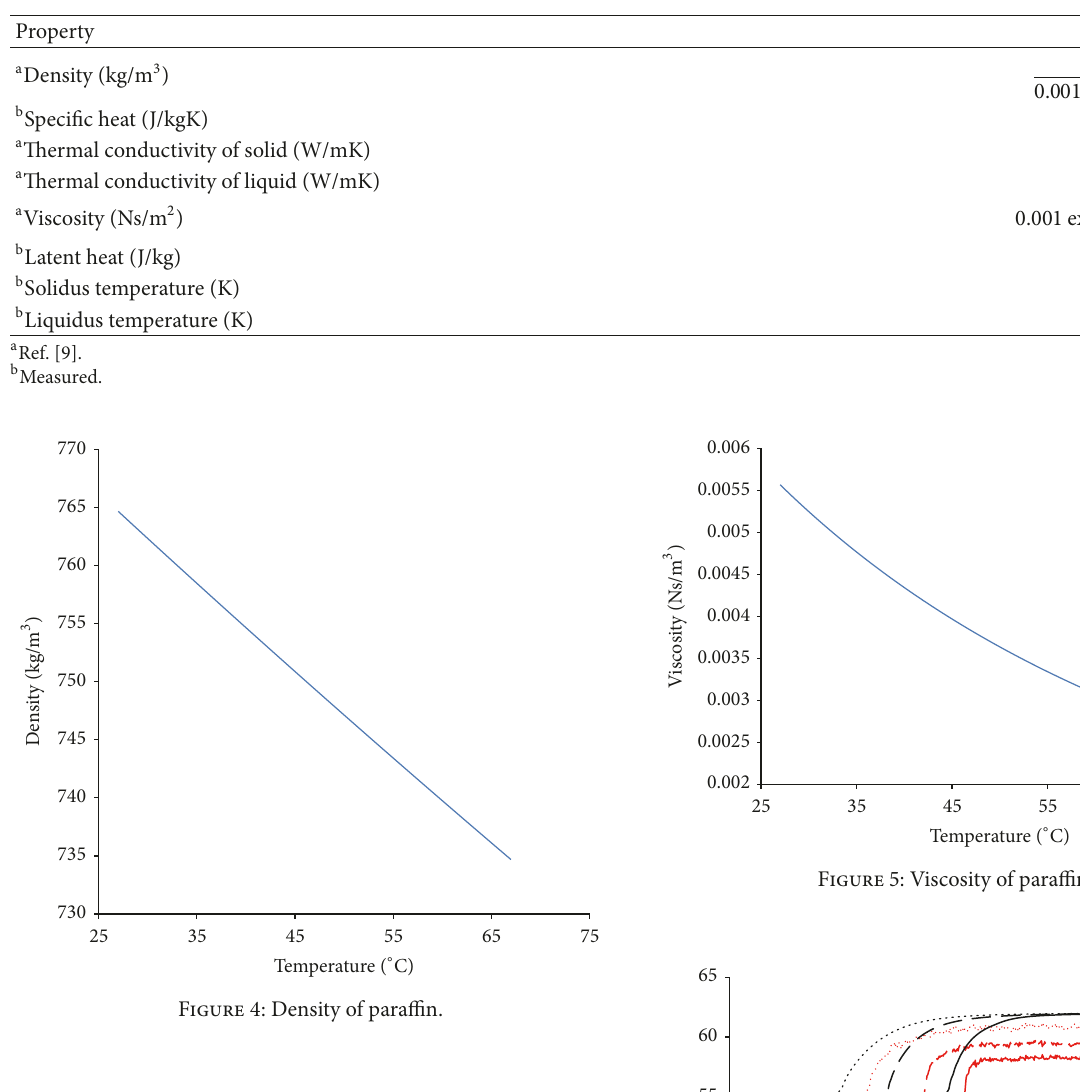
Table 1: The properties of paraffin.